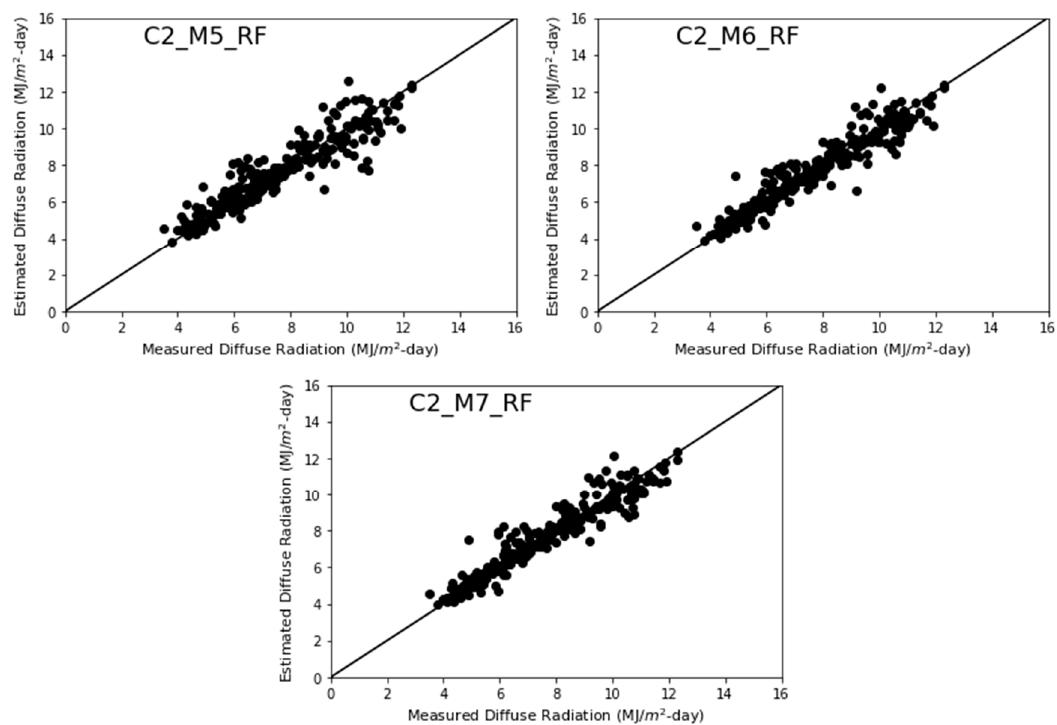
Figure 5. Plot depicting predicted and measured DSR from RF ML models (Category 2).